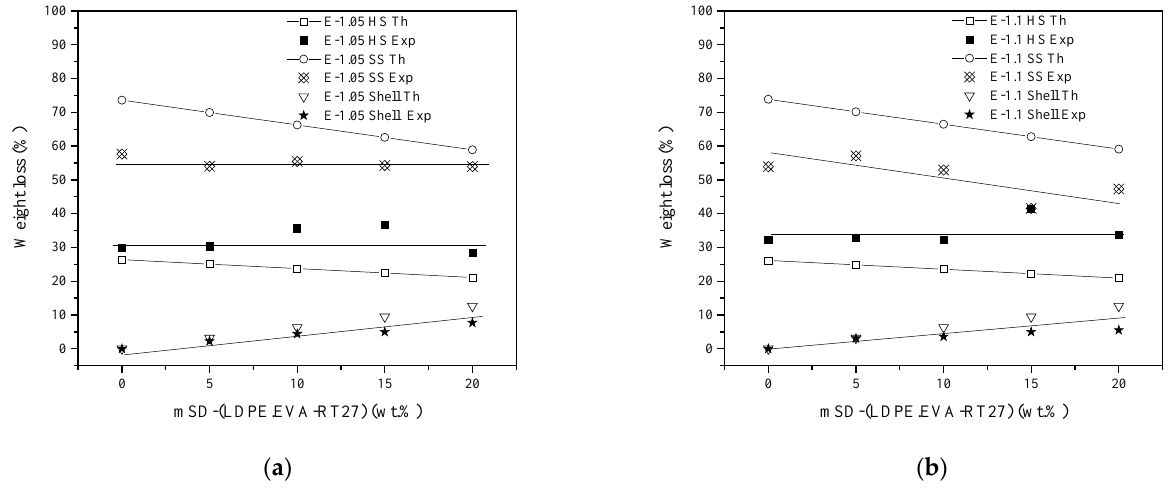
Figure 7. Experimental and theoretical weight loss for the SS, HS and microcapsule shells, depending on the mSD- (LDPE·EVA-RT27) content, for [NCO]/[OH] molar ratios of ( a ) 1.05 and ( b ) 1.1. The straight lines indicate the linear trends of the weight loss.